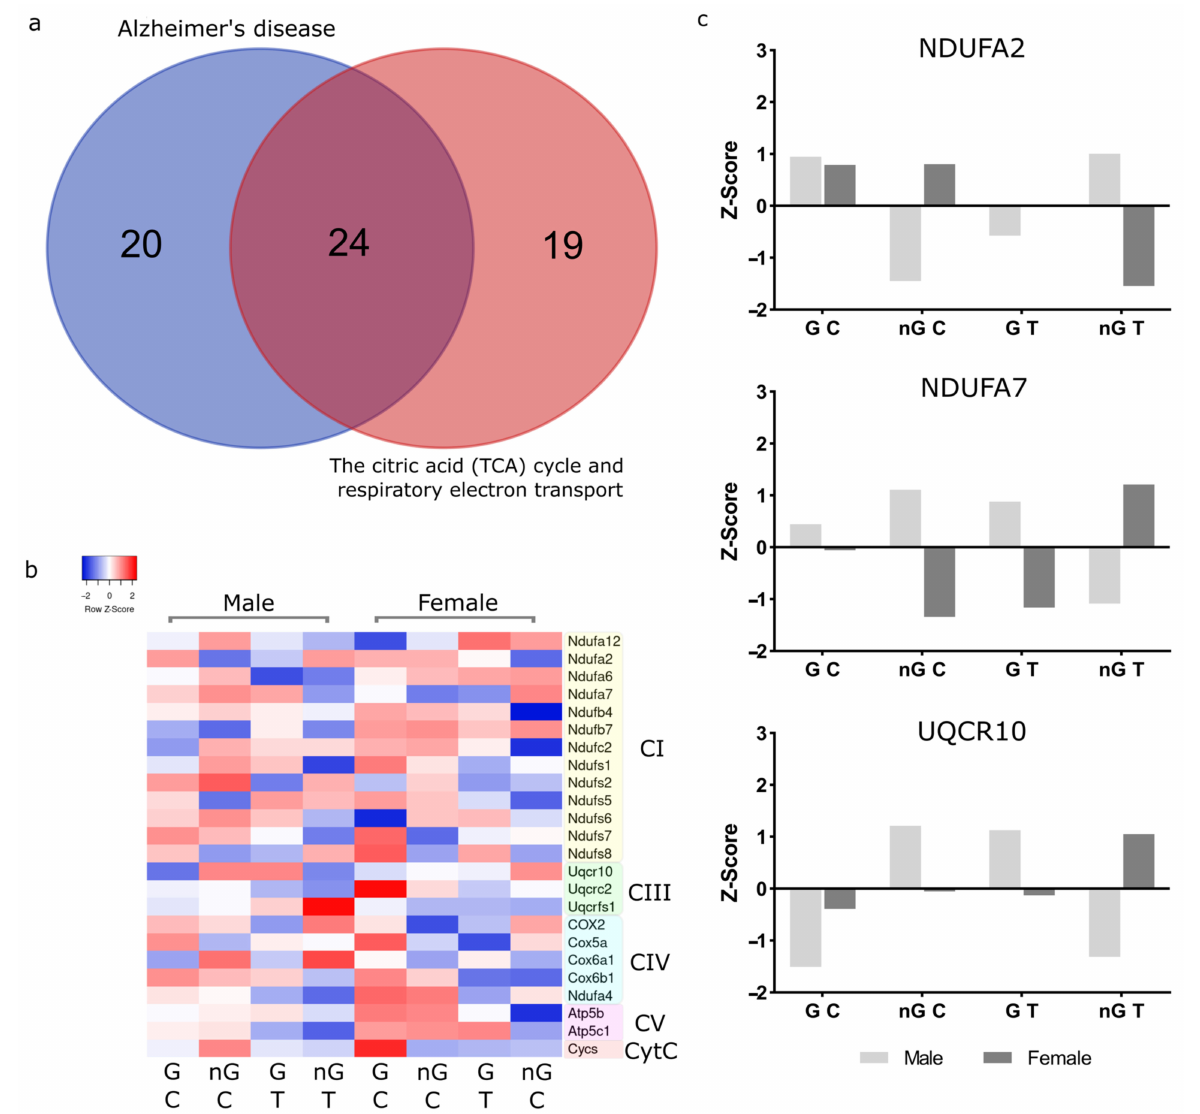
Figure 9. Metascape output and top regulated proteins in relation to sex, gonads and Tibolone. The top two enriched functions from the Metascape analysis of all protein lists were Alzheimer’s disease and the citric acid cycle and respiratory electron transport chain, which both belonged to the same cluster. We identified the 24 proteins shared between these functions ( a ) and members of the respirasome. A heatmap of the 24 respirasome proteins ( b ) was then produced, identifying members of complex 1, 3, 4 and 5 and cytochrome c. Only three of these proteins ( c ) were found to be significantly regulated by sex–gonad–Tibolone interactions: NDUFA2 ( p = 0.042) and NDUFA7 ( p = 0.0047) belonging to complex 1, and UQCR10 ( p = 0.043), which belongs to complex 3 of the